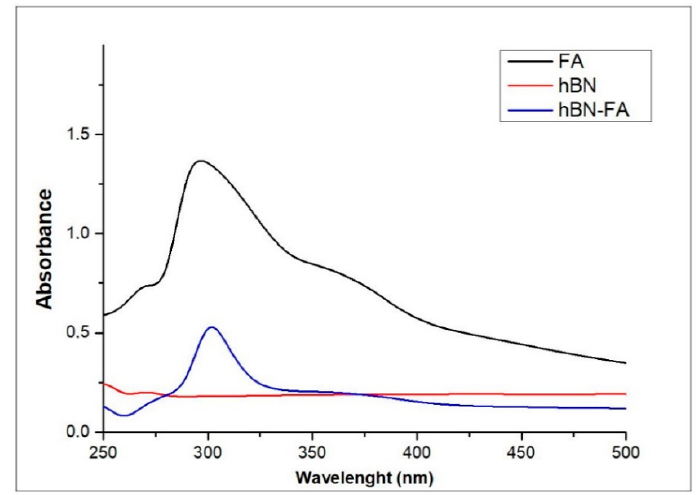
Figure 4. UV-vis spectrum of hBN, FA and hBN-FA.